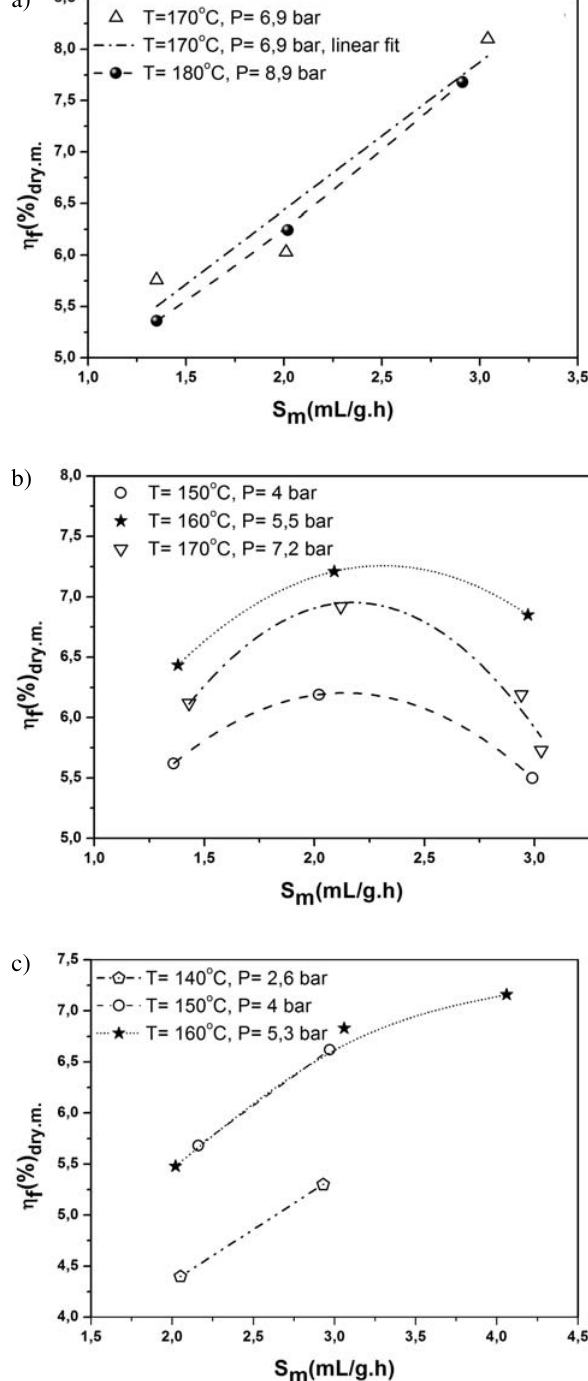
Figure 4. Influence of temperature, pressure and stripping module on furfural yield in catalysed process using a) 3.7% sulphuric acid solution, b) 38% solution of sulphuric acid and c) 90% sulphuric acid solution; the curves are eye